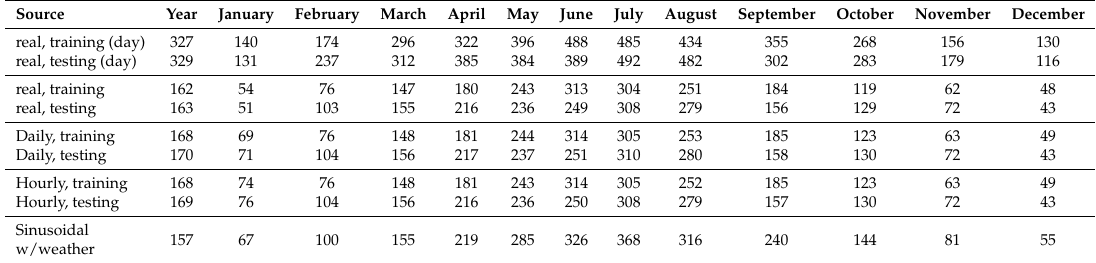
Table 4. Yearly and monthly average powers for Portland, Oregon (W/m 2 ).